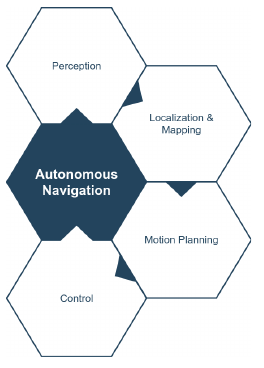
Figure 5. Modular software structure for UAV navigation